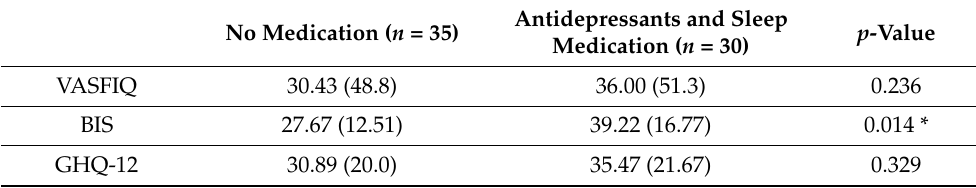
Table 4. Comparison of participants who used no medication with participants who used antidepres- sants and sleep